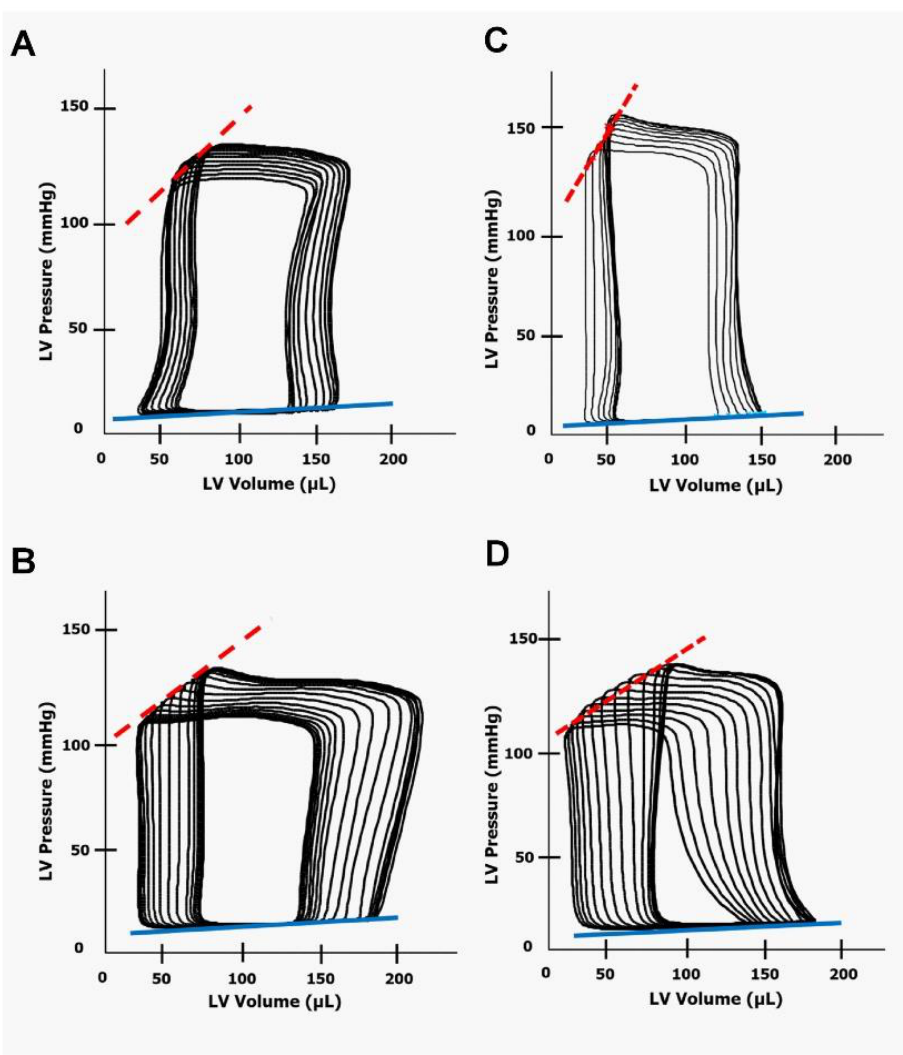
Figure 7. Representative steady-state loops from the pressure-volume analysis performed in ( A ) untreated normotensive, transgene-negative Hannover Sprague-Dawley (HanSD) rats, ( B ) HanSD rats two weeks after the last doxorubicin injection (i.e., at the end of the experimental protocol), ( C ) untreated hypertensive, Ren-2 transgenic (TGR) rats and ( D ) TGR after doxorubicin administration. ESPVR, end-systolic pressure volume relationship (dotted red line). EDPVR, end-diastolic pressure volume relationship (blue line).